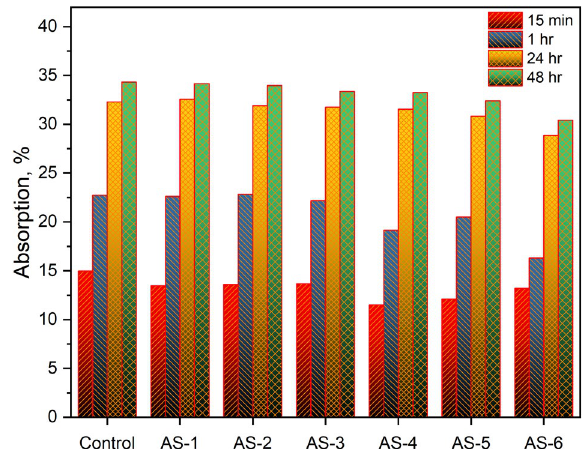
Figure 4. Water absorption of CNT-LWAC specimen.